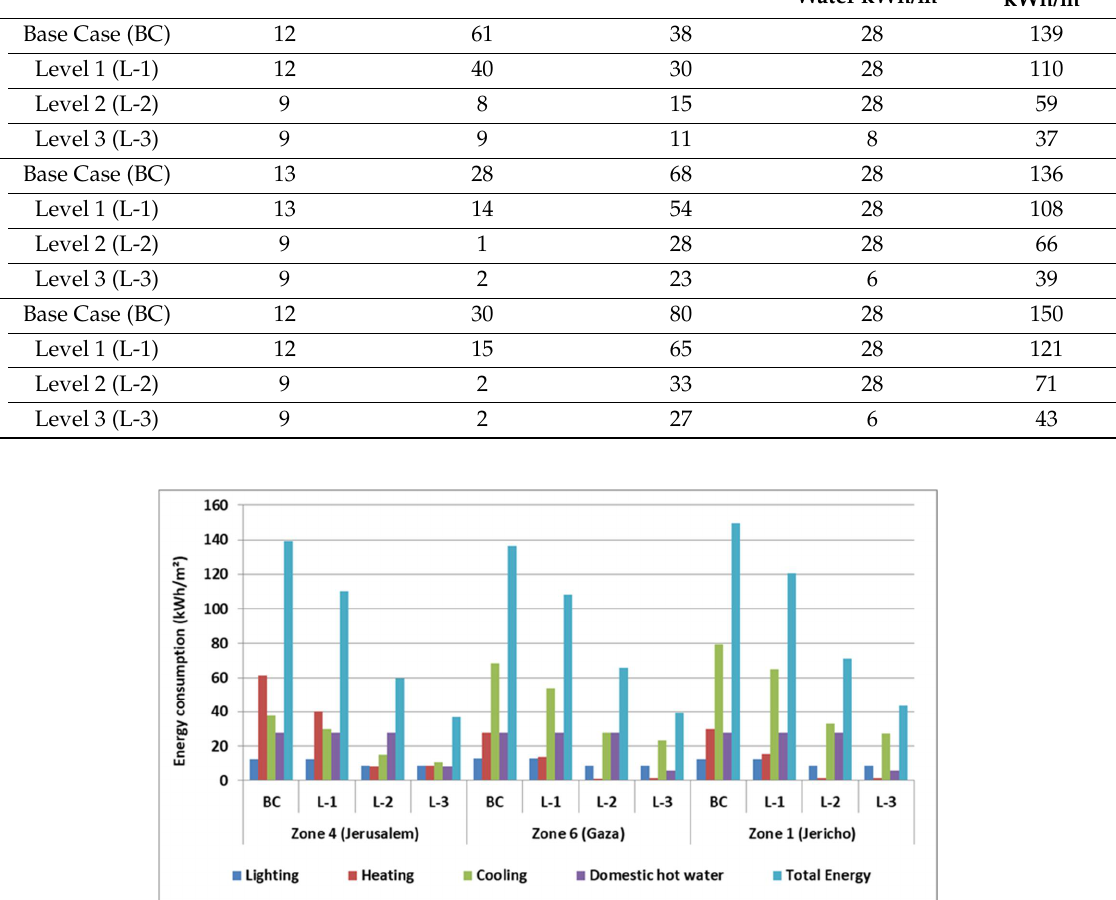
Figure 3. Total energy saving from applying the retrofitting plan for two residential units per floor area in different climate zones in Palestine.